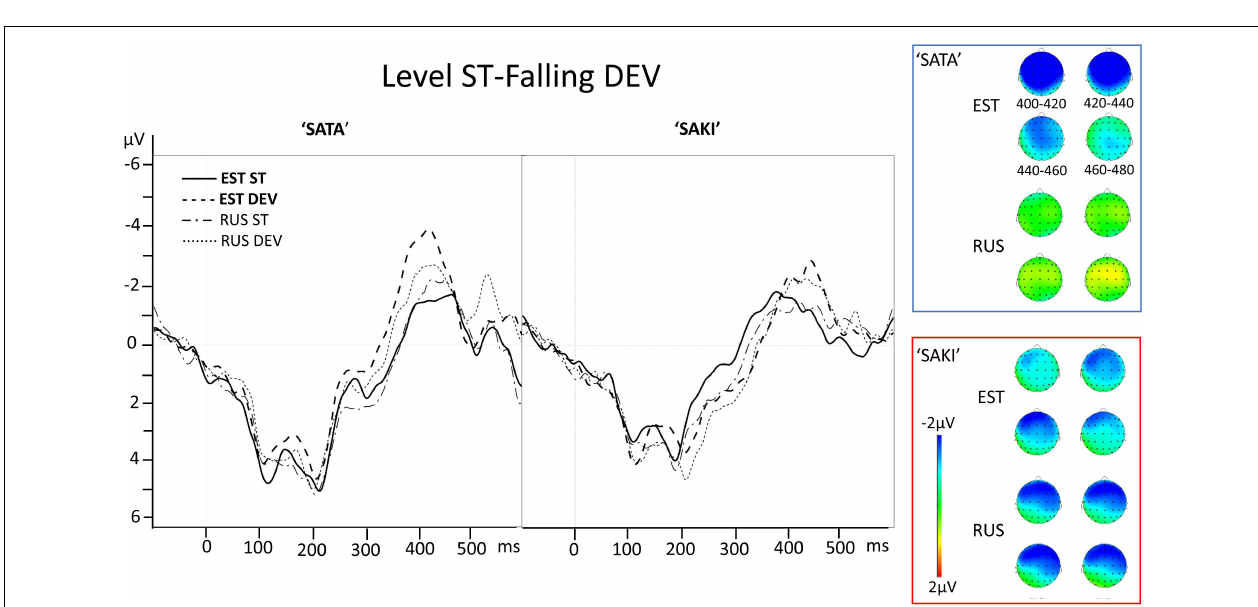
FIGURE 3 | Electrode AF3 averaged ERP activity for standard (ST) and deviant (DEV) stimuli in ‘Long ST-Short DEV’ comparisons for ‘SATA’ and ‘SAKI’ stimuli in Estonian (EST) and Russian (RUS) Language groups. Right panel represents distribution of averaged mismatch response (DEV-ST) in 400–480 ms. Please observe, that first 83–100 ms are exactly the same for ST and DEV under comparison (consonant, see stimuli in Figure 1 ).